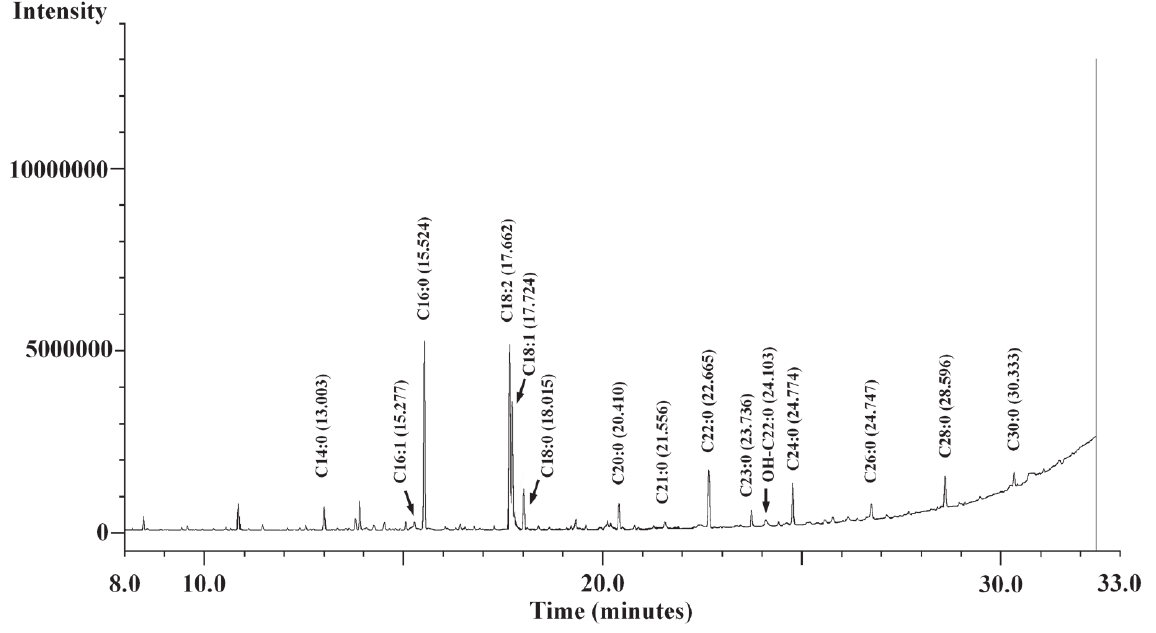
Figure 1 . Gas chromatography (GCMS) of lipids from Sarcocornia ambigua fertile shoot meal extracted with a mixture of Chloroform and Methanol 2:1